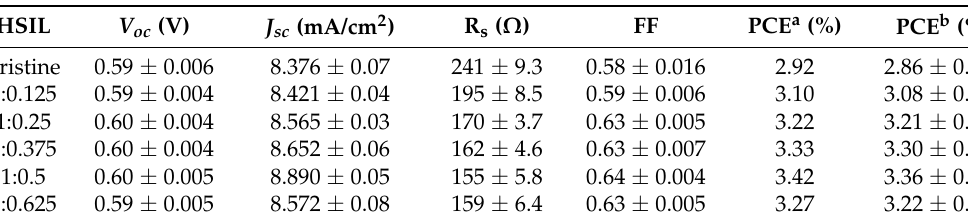
Table 1. PV parameters of the BHJ-PSCs fabricated with PEDOT:PSS and PEDOT:PSS-ET in different volume ratios. The average parameters were obtained from eight independent devices. PCE a and PCE b are the best and average PCE values, respectively.